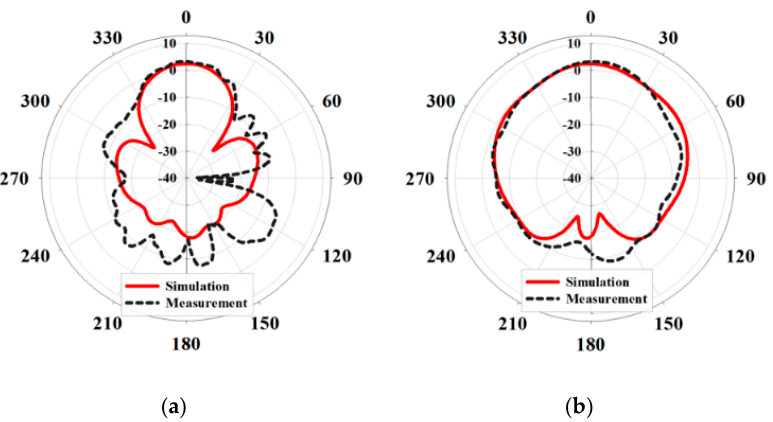
Figure 8. Measured and simulated antenna radiation patterns at 868 MHz: ( a ) E-plane; ( b ) H-plane.